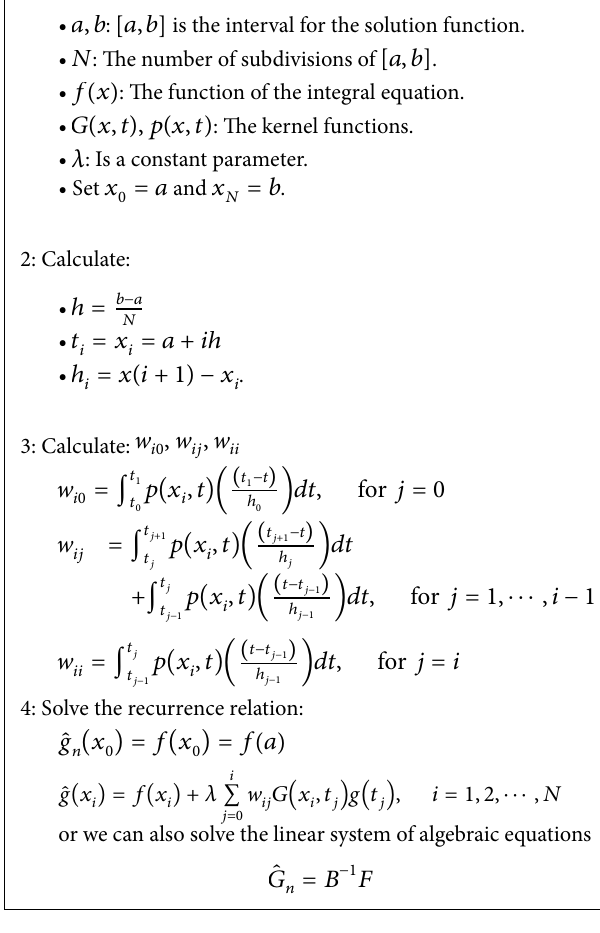
Algorithm 2: Numerical realization using the product integration method